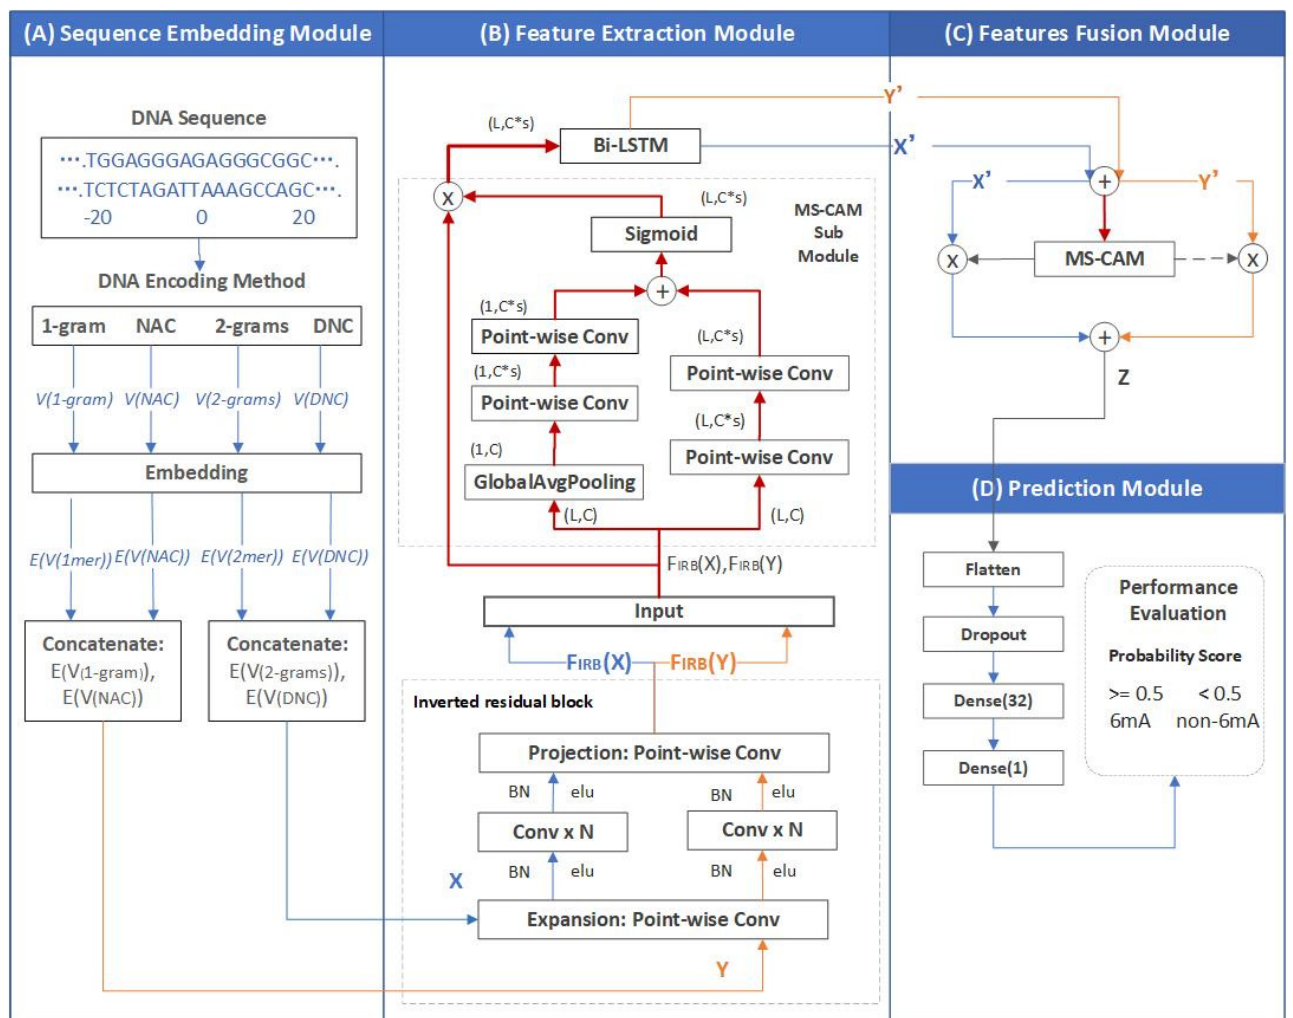
Figure 1. The flowchart of 6mAPred-MSFF. The sequence embedding module uses four different encoding schemes (1-gram, NAC, 2-grams, DNC) for the input of the embedding layer. Next, the feature matrices are fed into the feature extraction module to capture and combine the global and local features, respectively. Afterwards, the local and global contexts of the four different encoding schemes are aggregated into the feature fusion module. Finally, the output of the feature fusion module is fed into the prediction module to predict the 6mA site of a certain species.